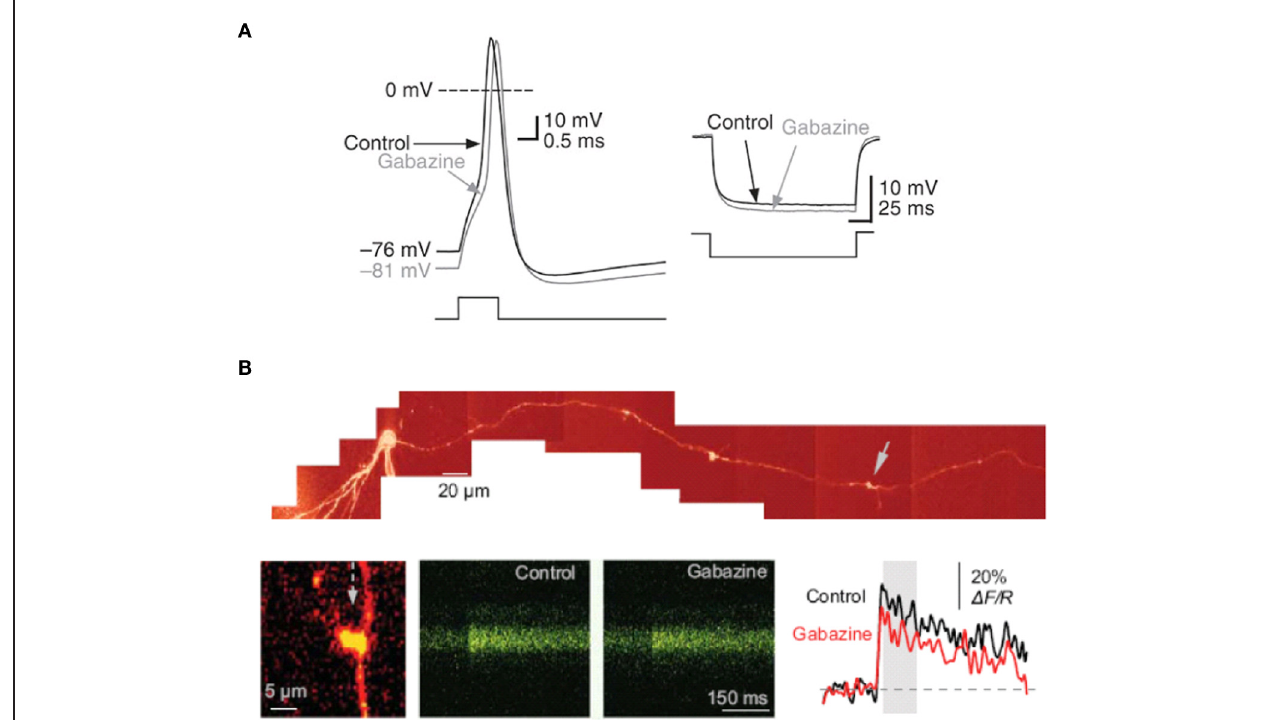
FIGURE 3 | Tonically-active GABA A receptor–mediated currents modulate the electrical properties of mossy fiber boutons. (A) Current-clamp recording from a mossy fiber bouton with 20mM [Cl − ] i . Left, sample traces showing the action potential before (black) and after (gray) superfusion of gabazine (5 μ M). Right, response to hyperpolarizing current injection showing an increase in mossy fiber input resistance in gabazine. (B) Tonically-active GABA A receptors enhance presynaptic action potential-dependent Ca 2 +